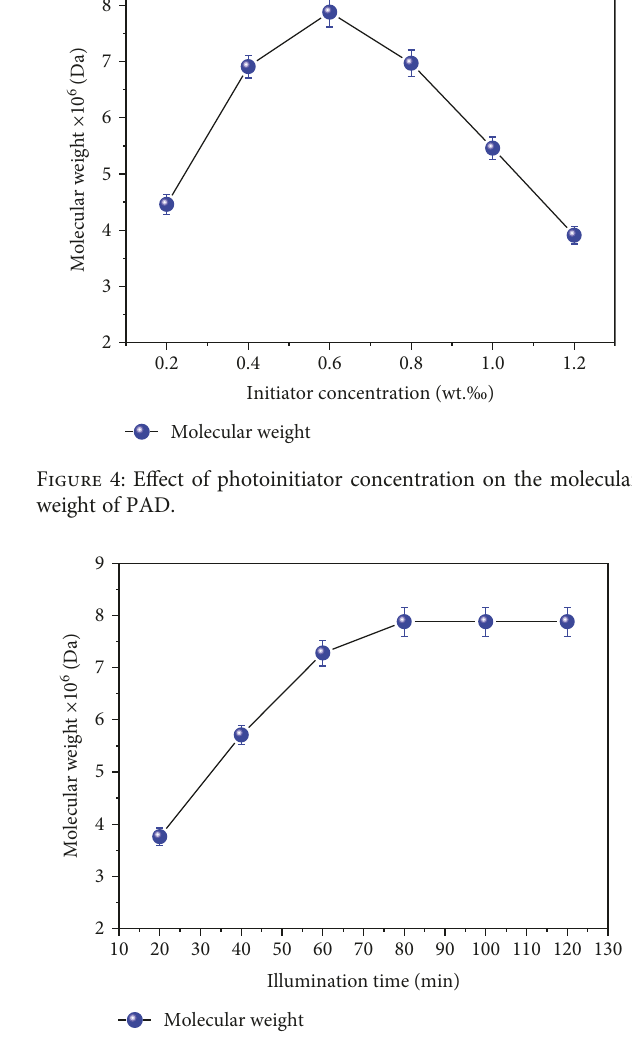
Figure 5: E ff ect of illumination time on the molecular weight of